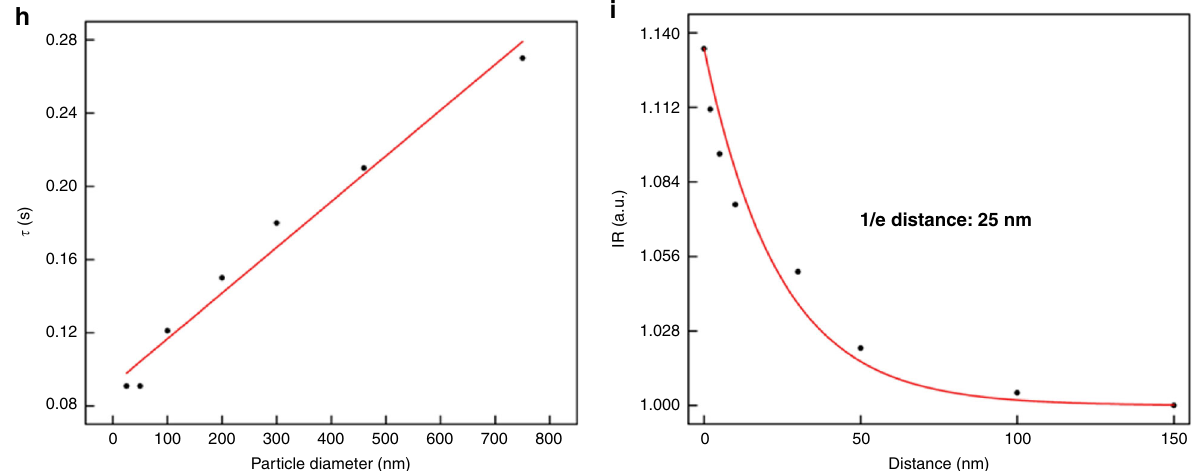
Fig. 5 Particle size vs. settlement time on AGNIS. PANORAMA IR change of a 25 nm, b 50 nm, c 100 nm, d 200 nm, e 300 nm, and f 460 nm PS beads as it settles on AGNIS. g The IR change of 750 nm PS bead as it settles on the surface via PANORAMA (red) and via bright- fi eld imaging (black). h Particle settlement time ( τ ) vs. particle size. τ was calculated from the points labeled 1 to 2 for all particle sizes in ( a – g ). i FDTD simulation of IR vs. distance between a 50 nm particle and AGNIS. Scale bar: 390 nm.